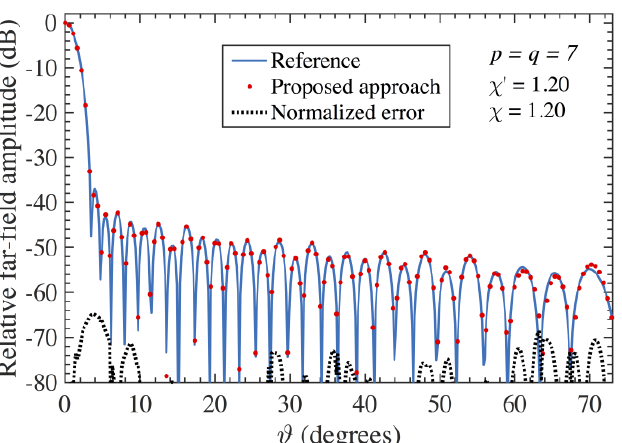
Figure 10. FF patterns in the E-plane—AUT 2. Blue line: reference. Red dots: attained from the positioning errors affected PWMS samples by using the proposed procedure. Dashed line: corresponding normalized error.